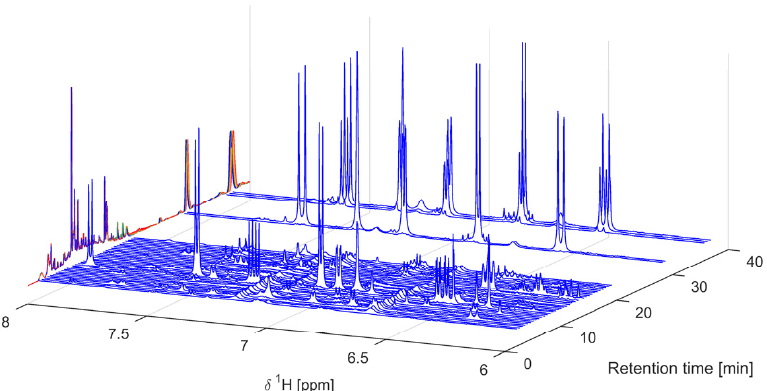
Figure 6. Expansion of 1 H-NMR spectra of the 40 fractions dissolved in DMSO- d 6 and plotted on the retention time axis according to their collection. The corresponding UV-chromatograms (first in blue color, last in red, intermediate in green and yellow, 20 in total) are plotted along the left-hand side.